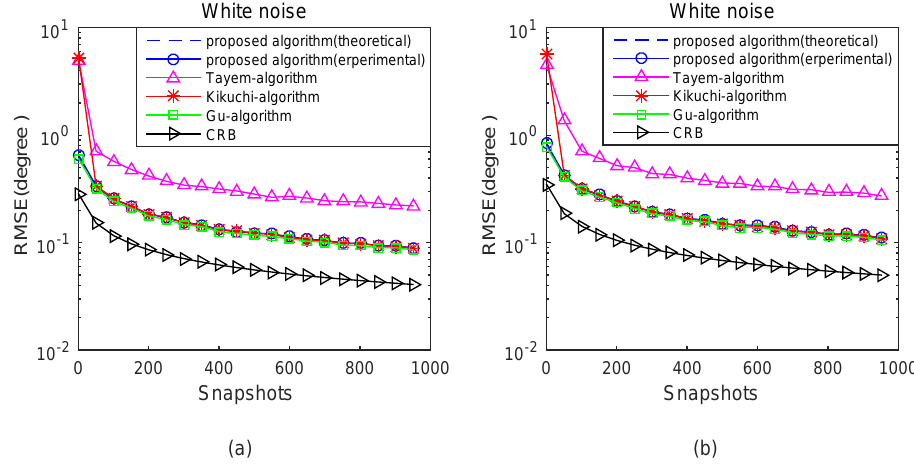
Figure 6. RMSE versus Snapshots in a white noise situation.( a ) s 1 ( t ) ; and ( b ) s 2 ( t )